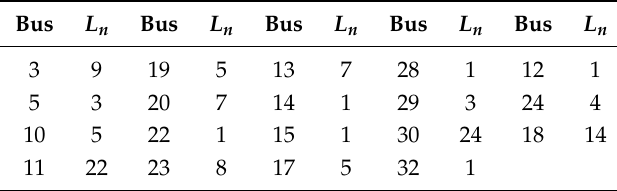
Table 4. No. of users per node L n